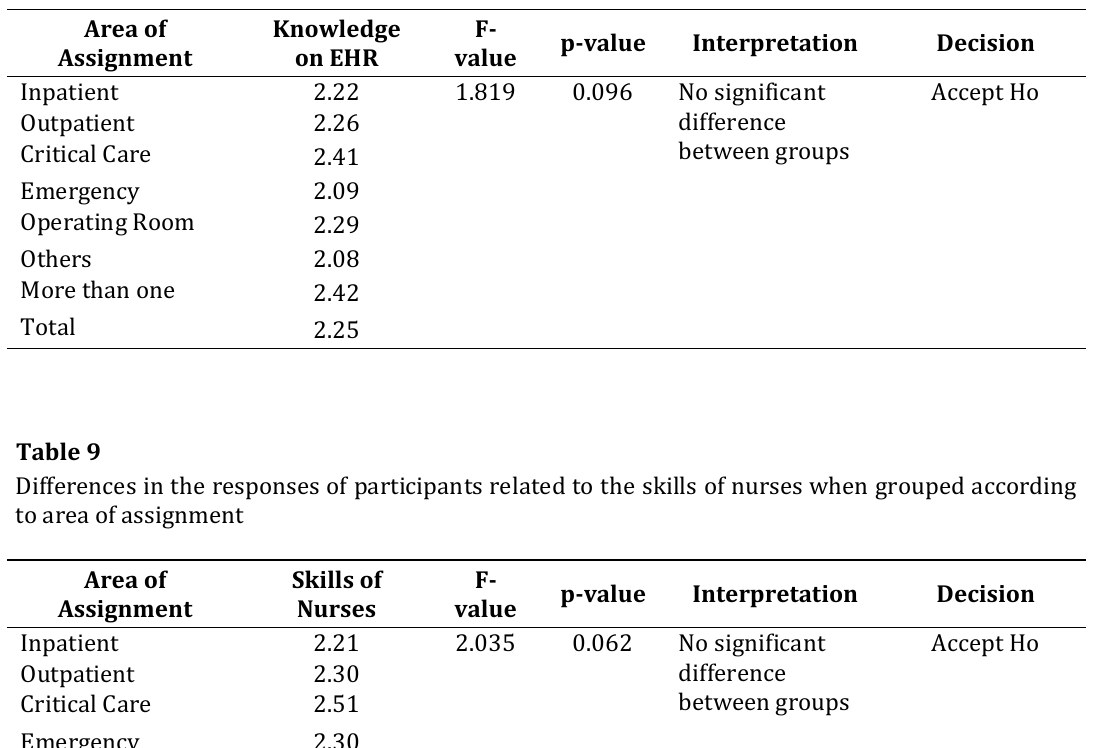
Differences in the responses of participants related to the knowledge of nurses when grouped according to area of assignment